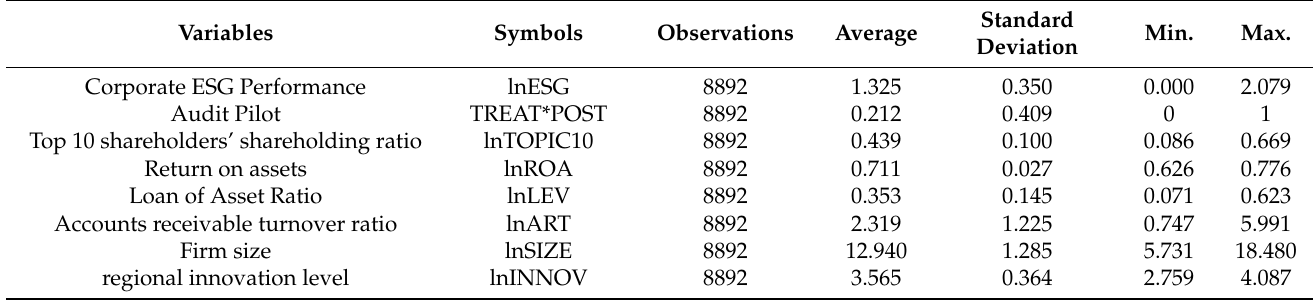
Table 3. Results of descriptive statistics of